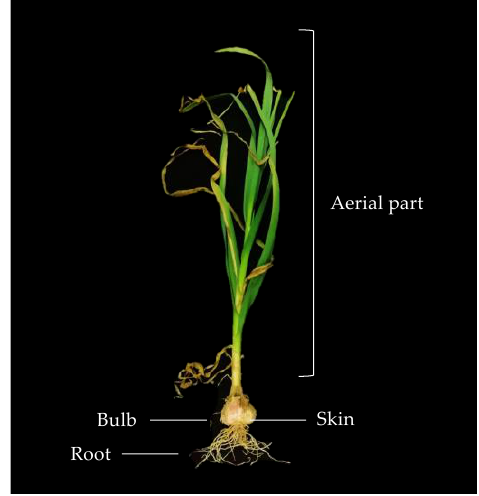
Figure 1. Morphology of a garlic bulb.